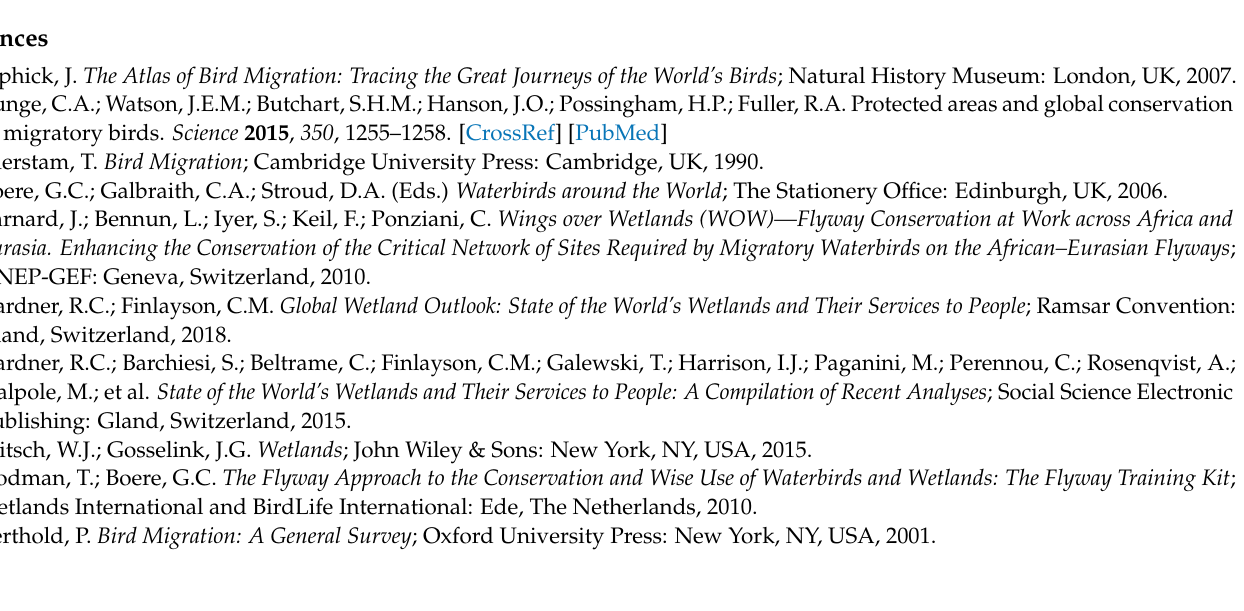
the summer period; Figure S2: Results of 10,000 null model simulations for the two indices C-score and number of checkerboard species pairs; Table S1: List of the avian species sampled in the Sicilian wetlands; Table S2: Description of the attributes of the 16 wetlands under study in Sicily; Table S3: Functional traits (diet, foraging, migration) of the bird species sampled in the Sicilian wetlands; Table S4: Pairwise dissimilarities in species composition among wetlands; Table S5: Idiosyncratic wetlands in Sicily; Table S6: Idiosyncratic bird species in the Sicilian wetlands; Table S7: Cross- tabulation analysis of species guilds; Table S8: Boundary-to-boundary distances among the wetlands under study; Table S9: List of the bird species with three or less occurrences out of 16